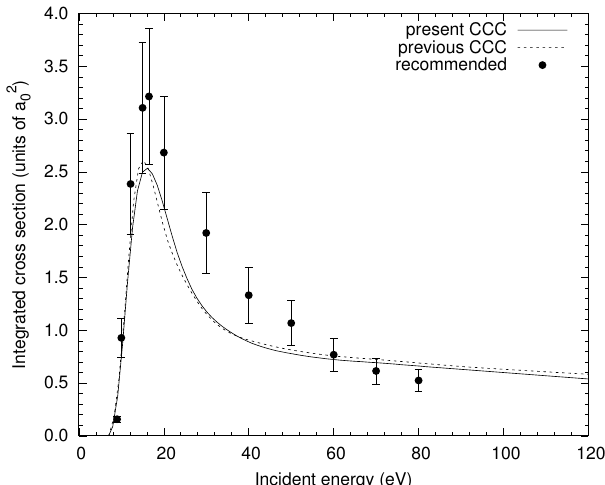
Figure 4. Electron-impact dissociation cross section for scattering on the ground (electronic and vibrational) level of H 2 , comparing the present results with our previous calculations [6] and the recommended cross sections of Yoon et al.